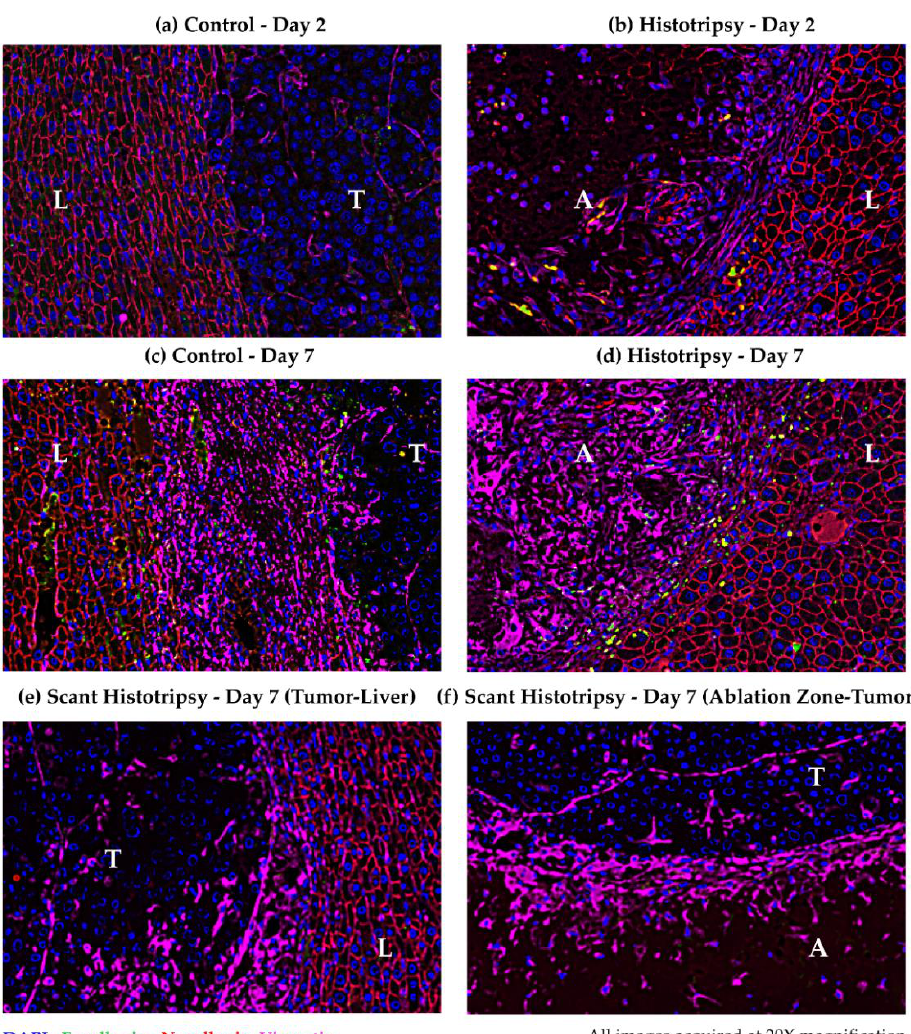
Figure 7. Representative multiplex immunohistochemistry images obtained at 20× magnification showing epithelial and mesenchymal markers in ( a ) untreated control (Day 2), ( b ) histotripsy- treated tumor (Day 2), ( c ) untreated control (Day 7), ( d ) histotripsy-treated tumor (Day 7), and ( e , f ) scant histotripsy treated (<25% tumor volume ablated) tumor (Day 7). All days are measured from the histotripsy-treatment timepoint. The samples were stained for DAPI (blue), E-cadherin (green),